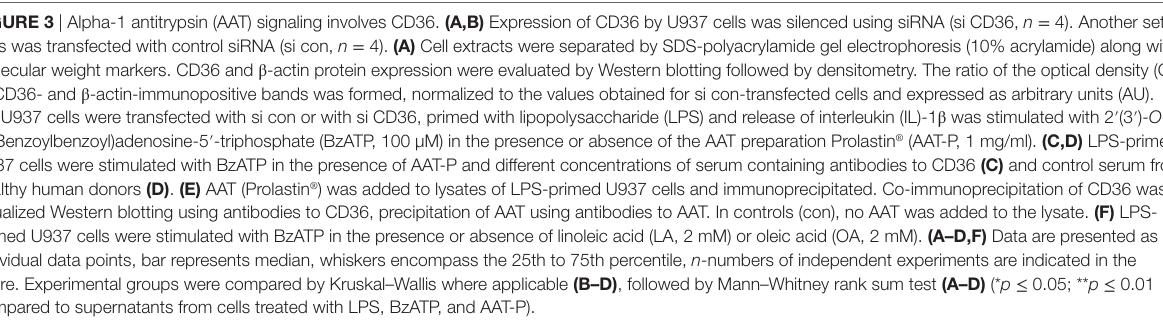
FigUre 3 | Alpha-1 antitrypsin (AAT) signaling involves CD36. (a,B) Expression of CD36 by U937 cells was silenced using siRNA (si CD36, n = 4). Another set of cells was transfected with control siRNA (si con, n = 4). (a) Cell extracts were separated by SDS-polyacrylamide gel electrophoresis (10% acrylamide) along with molecular weight markers. CD36 and β -actin protein expression were evaluated by Western blotting followed by densitometry. The ratio of the optical density (OD) of CD36- and β -actin-immunopositive bands was formed, normalized to the values obtained for si con-transfected cells and expressed as arbitrary units (AU). (B) U937 cells were transfected with si con or with si CD36, primed with lipopolysaccharide (LPS) and release of interleukin (IL)-1 β was stimulated with 2 ′ (3 ′ )- O -